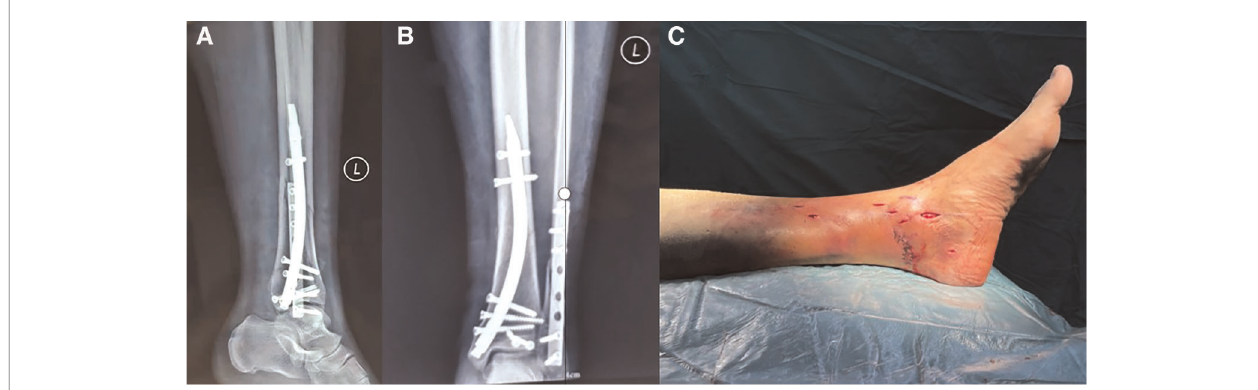
FIGURE 3 | ( A ) X-ray orthopantomogram at one month after1 closed reduction RTN internal fi xation of distal tibial fracture; ( B ) X-ray lateral radiograph at one month after1 closed reduction RTN internal fi xation of distal tibial fracture; ( C ) surgical incision of the affected limb after closed reduction RTN internal fi xation of distal tibial